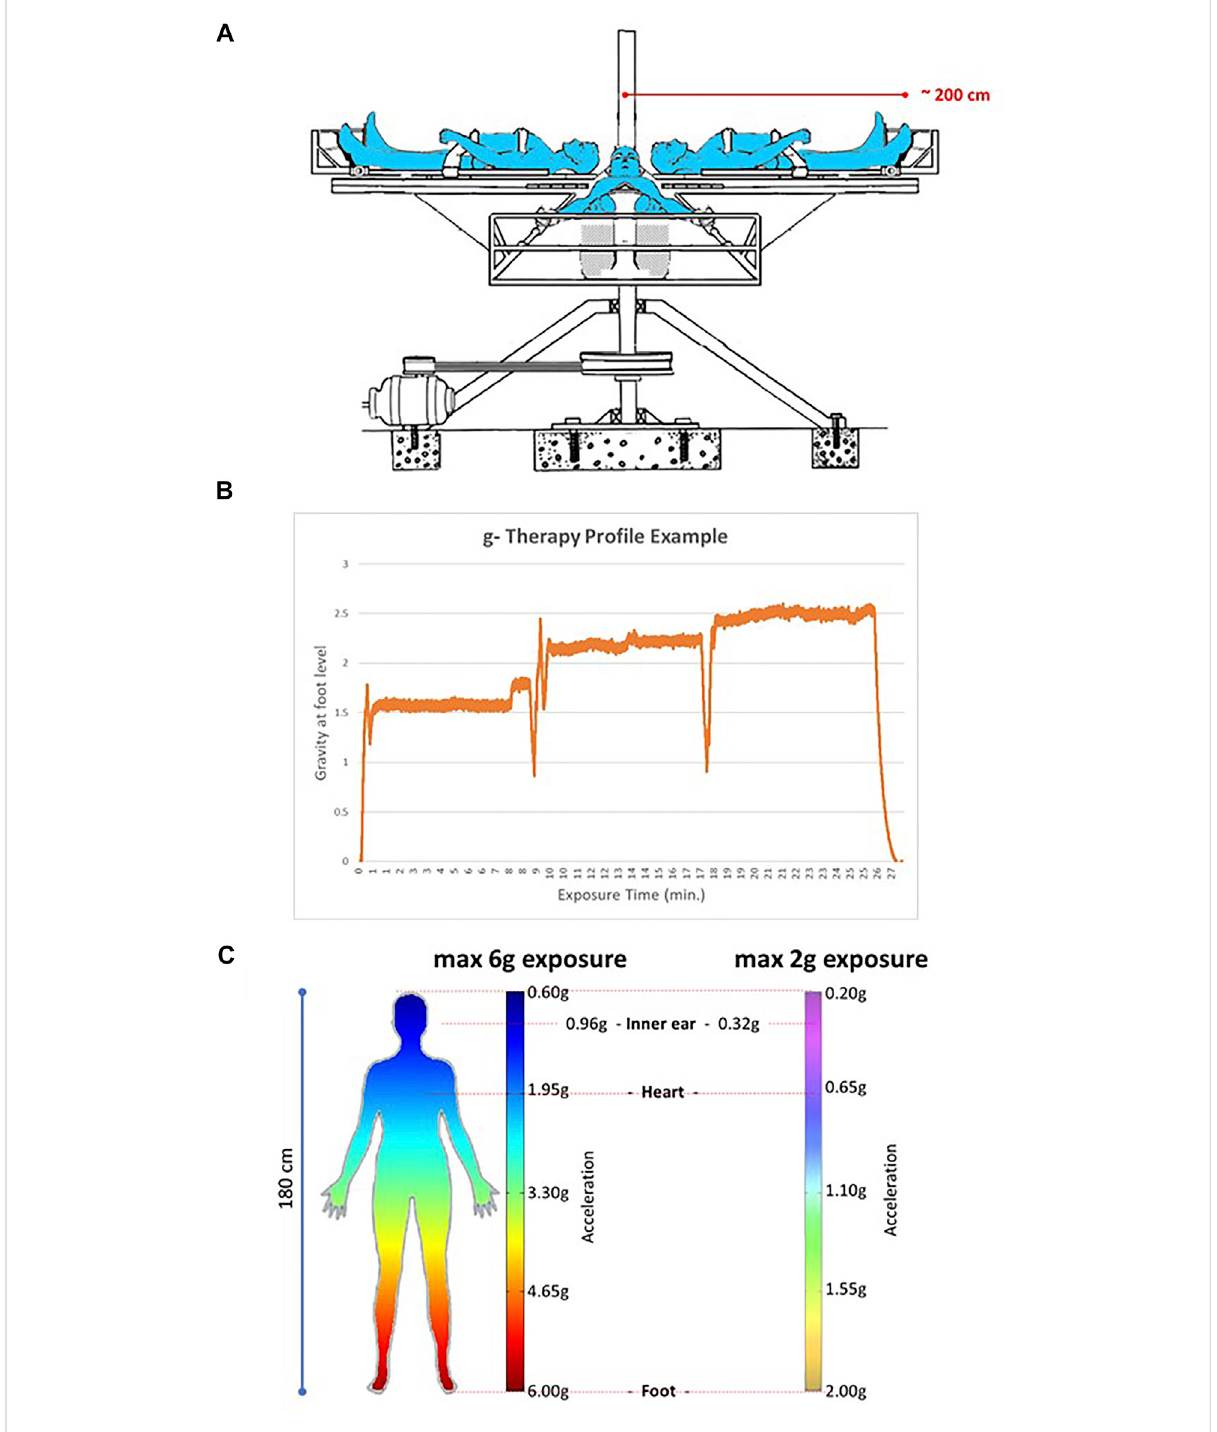
FIGURE 1 Centrifuge as currently used at the Gravity Therapy Center (GTC) in Montevideo, Uruguay. (A) Con fi guration of the nearly 2-m diameter centrifuge used for GT sessions at the GTC. A maximum of 4 patients can be accommodated in one session. (B) An example of a g pro fi le used nowadays. The pro fi le might be adapted based on patient ’ s tolerance, medical condition or age. (C) Gravity gradient over the patient ’ s 180 cm tall body when exposed to a maximum of 6 g or 2 g in a 2-m diameter system. Note that for the 6 g system the g at heart level is ~1.95 g and at the level of the inner ear/vestibular system nearly 0.96 g. For the 2 g this is 0.65 and 0.32,